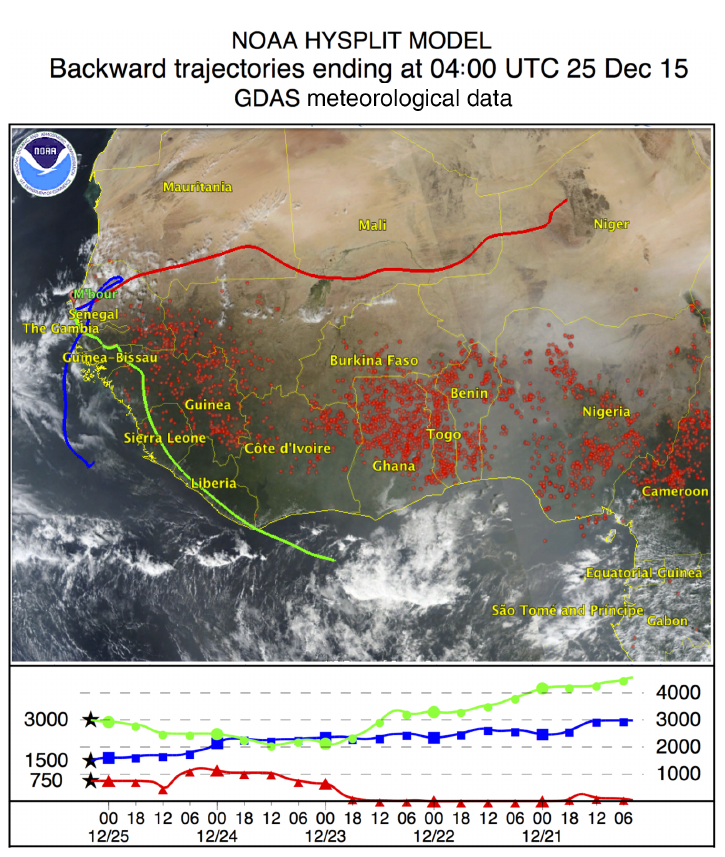
Figure 1. Five-day backward trajectories for the air mass in Mbour at altitudes 750, 1500, and 3500m, on 25 December 2015 at 04:00UTC, together with the map of forest fires on 20 December